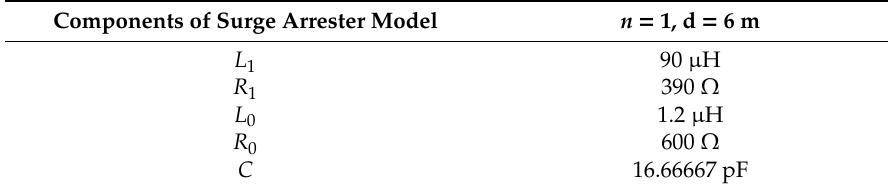
Table 3. Parameters of the surge arrester